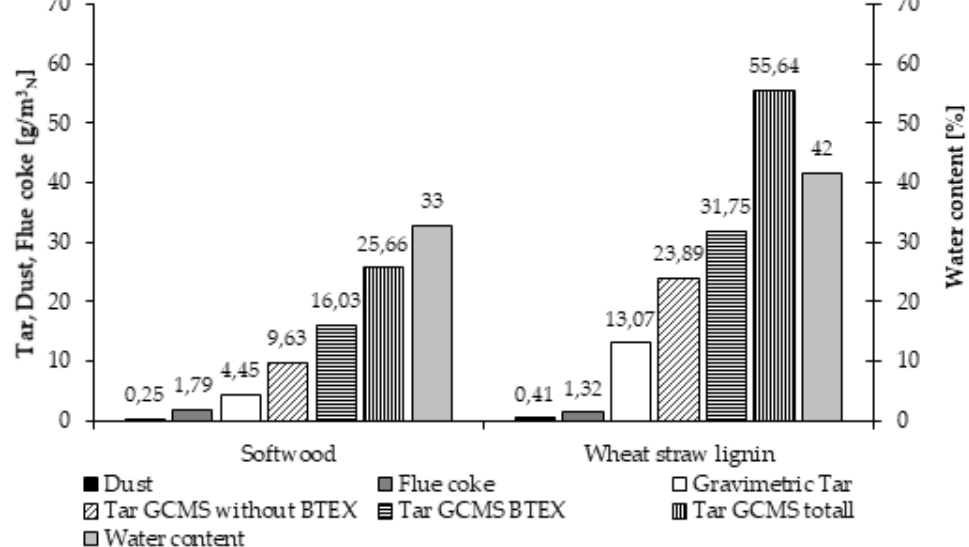
Figure 4. Left: Amount of tar, dust, flue coke and water in product gas from gasification of softwood. Right: Amount of tar, dust, flue gas and water in product gas from gasification of wheat straw lignin.